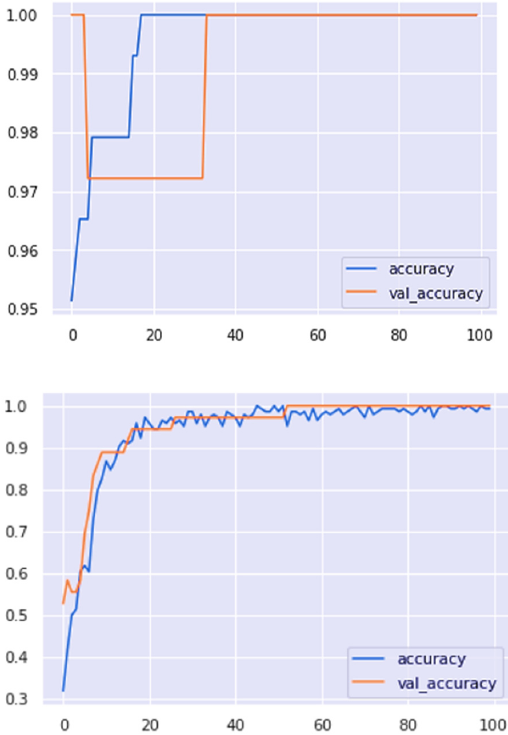
Figure 12. Accuracy curve of the model without and with dropout and batch normalization.